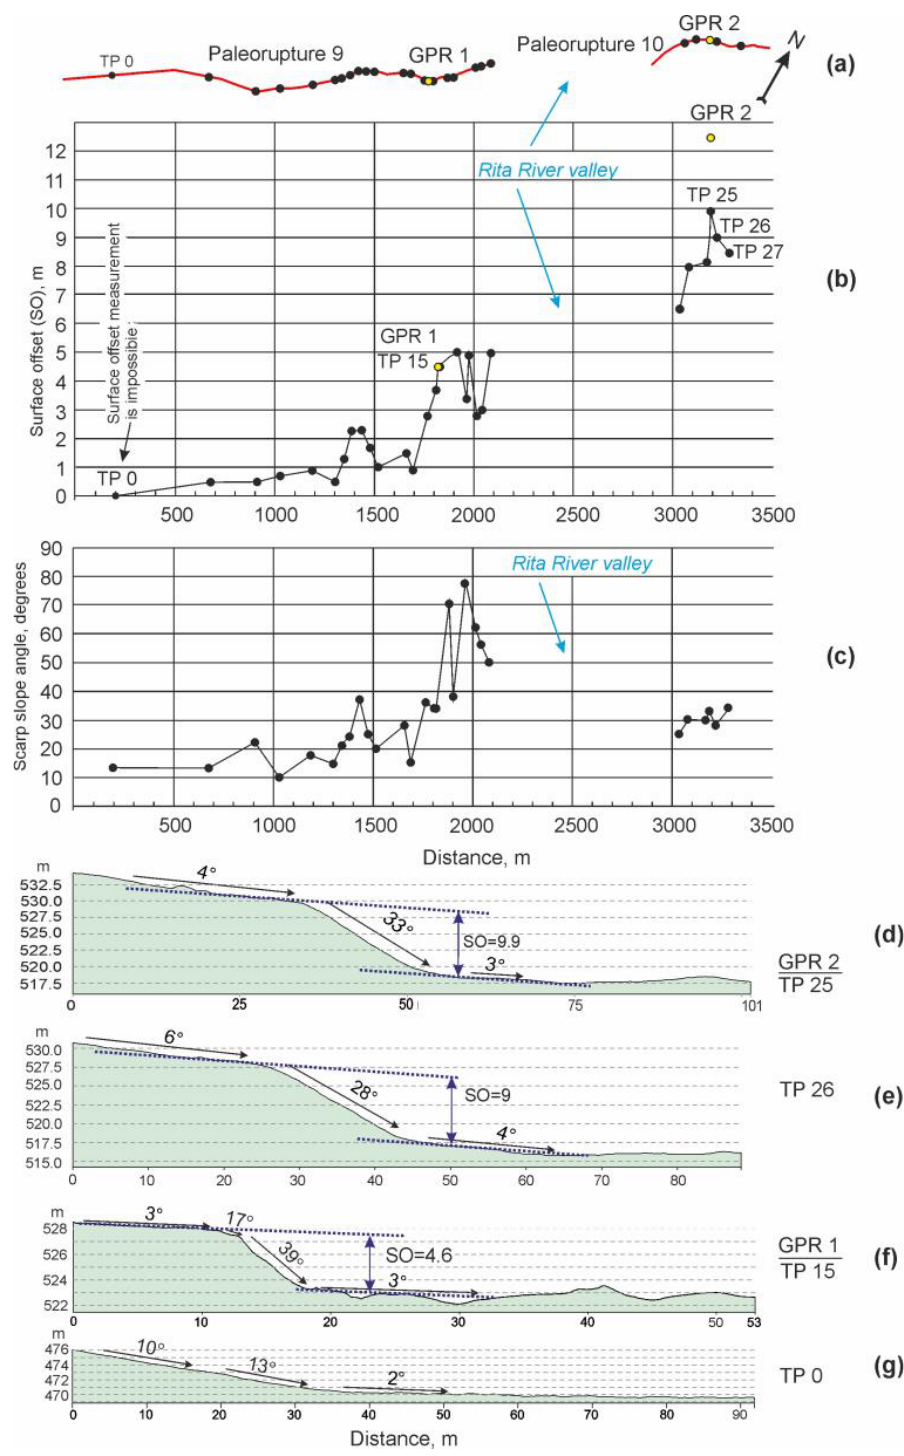
Figure 13. Results of topographic measurements: ( a ) paleoseismic ruptures R - 9 and R - 10; ( b ) changing of surface offsets along ruptures R - 9 and R - 10; ( c ) variation of scarp slope angle; ( d – g ) some topographic profiles (TP) across fault scarps. Black point indicates measurement of SO, yellow point shows full offset of GPR facies (see Figures 10 and 11).